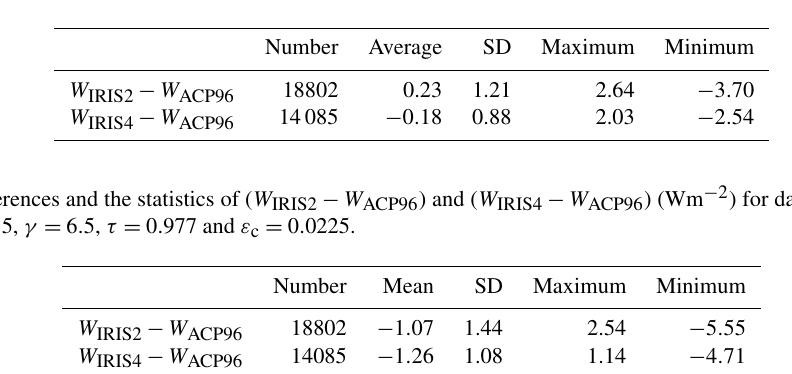
Table 2. The mean differences and the statistics of ( W IRIS2 − W ACP96 ) and ( W IRIS4 − W ACP96 ) (Wm − 2 ) for data from January to Novem- ber 2020, using C = 10 . 5, γ = 8 . 4, τ = 0 . 977 and ε s = 0 . 0225.